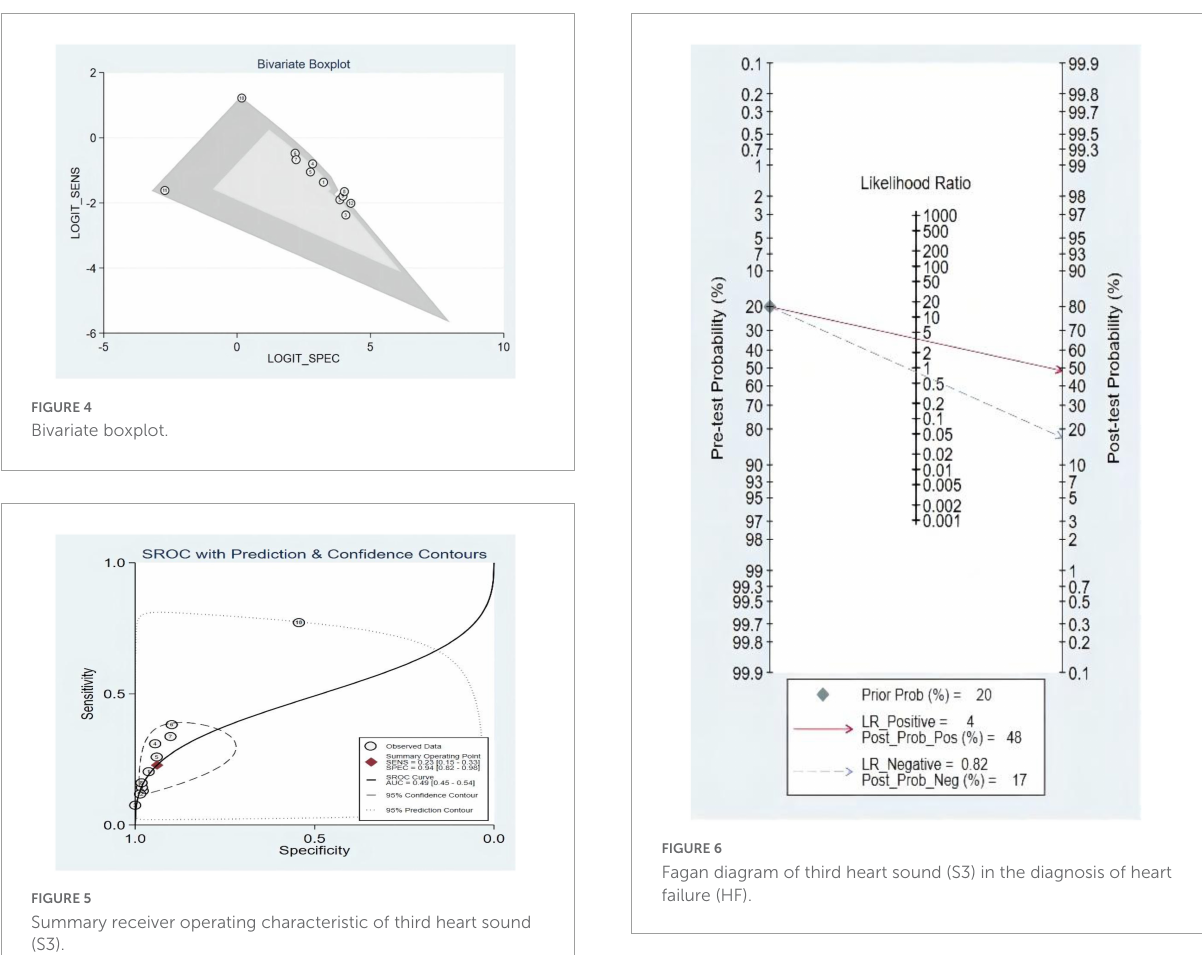
FIGURE5 Summary receiver operating characteristic of third heart sound (S3).